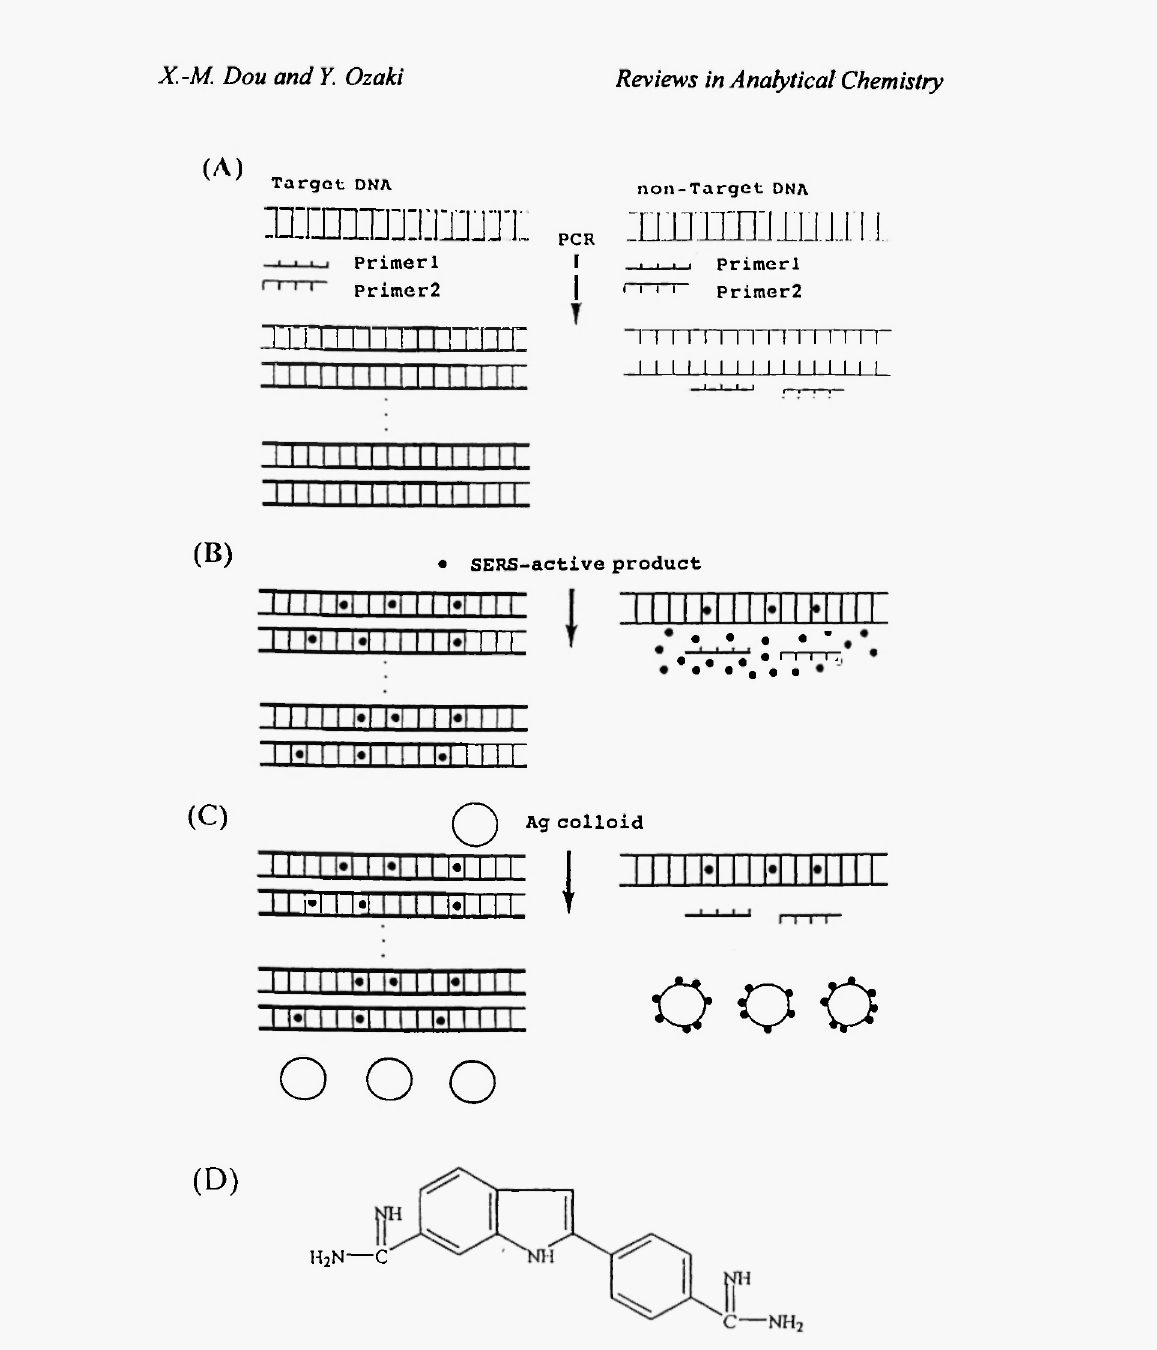
Fig. 13: (A) - (C) Principle for quantitative analysis of ds - DNA amplified by PCR utilizing SERS. (D) 4'.6 - diamidino-2-phenylindole dihydrochloride